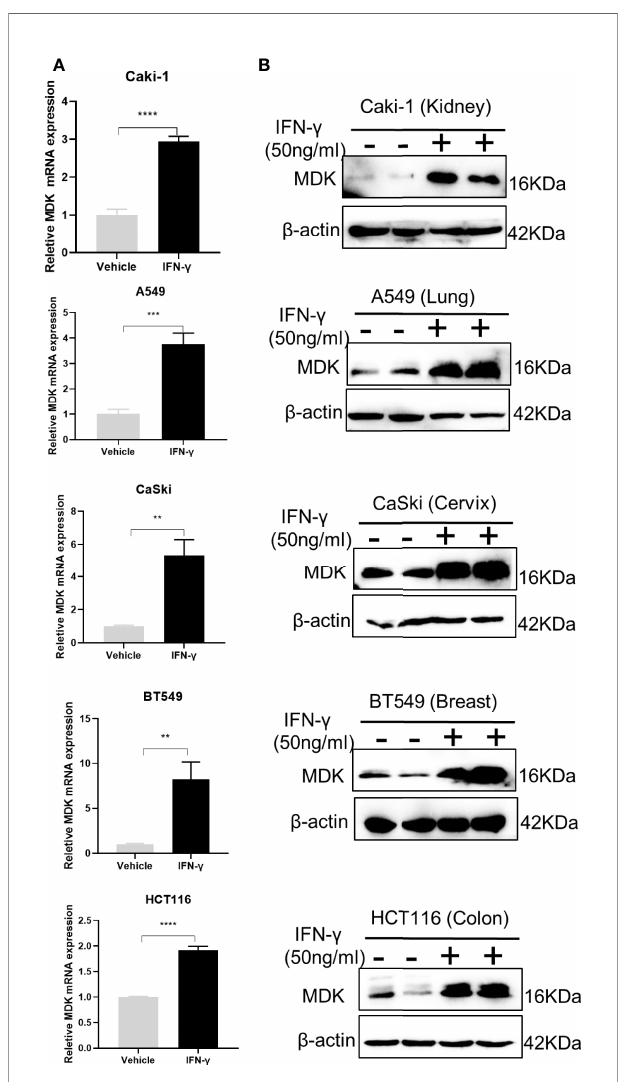
FIGURE 2 | IFN- g treatment promotes MDK expression in different cancers. (A) RT-qPCR assays to detect the expression of MDK in fi ve cancer cell lines without and with IFN- g treatment (50 ng/ml, 48 h). (B) Western blotting assay to determine the in fl uence of IFN- g treatment (50 ng/ml, 48 h) on MDK protein levels in fi ve cancer cell lines. Data are shown as the mean ± standard deviation (SD). **P < 0.01, ***P < 0.001, ****P <